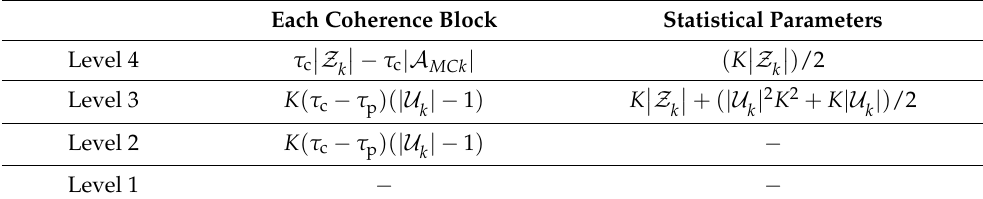
Table 2. Number of complex scalars that other CPUs send to the Master CPU through the backhaul, either in each coherence block or for each realization of the UE